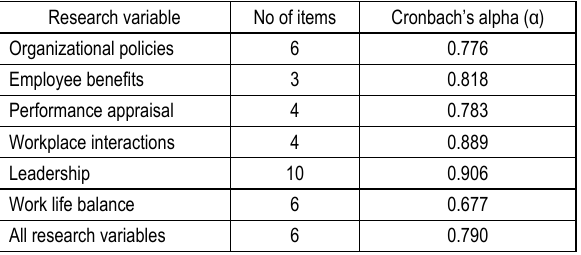
Table 1. Reliability table for the research